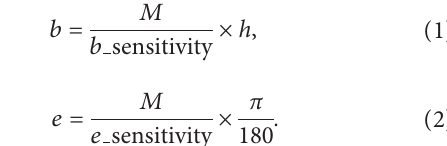
Figure 1: A diagram of a tennis training